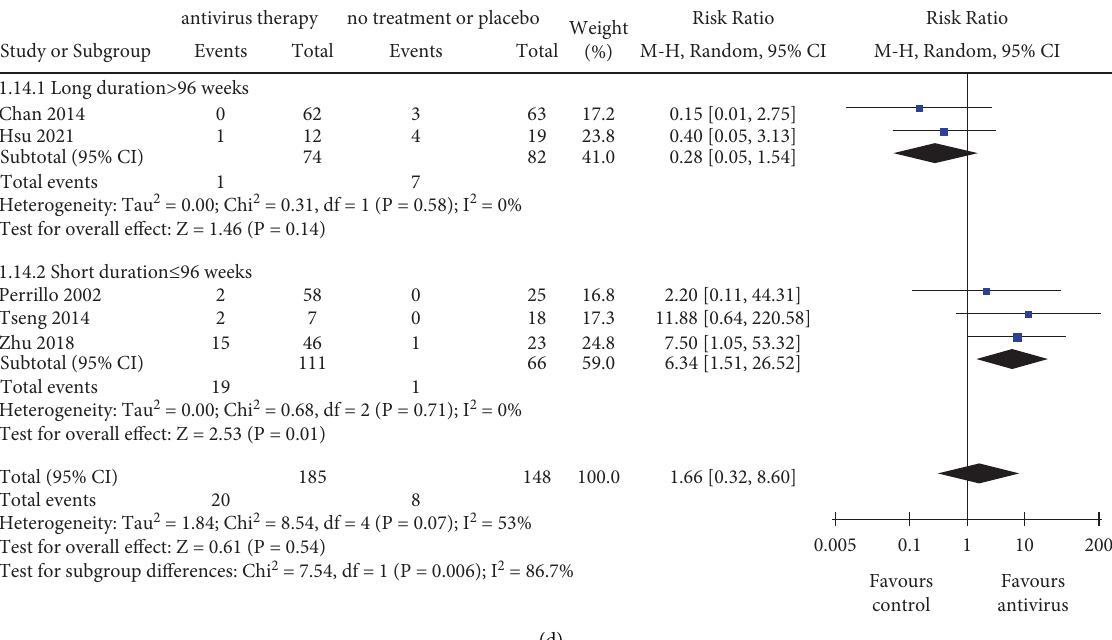
Heterogeneity: Tau 2 = 1.84; Chi 2 = 8.54, df = 4 (P = 0.07); I 2 = 53% Test for overall efect: Z = 0.61 (P = 0.54) Test for subgroup diferences: Chi 2 = 7.54, df = 1 (P = 0.006); I 2 =